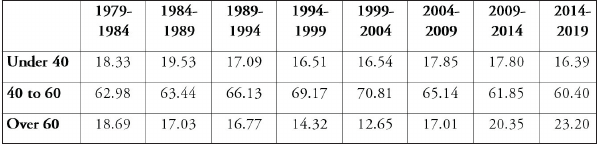
Table 2: Age distribution through the eight parliamentary terms, at the start of a term (percentage)